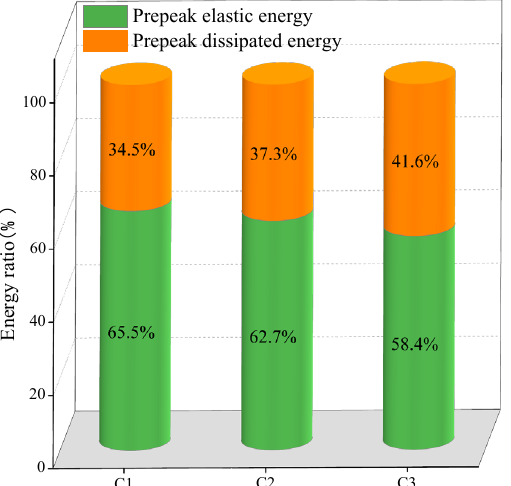
Figure 21. Prepeak energy distribution of sandstone–CGFB composite samples.